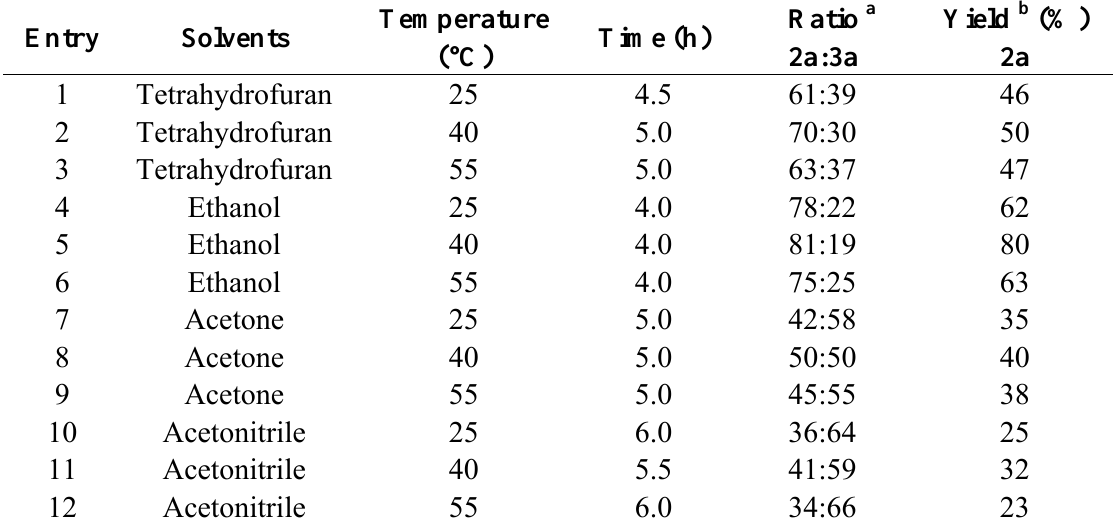
Table 1. Solvent effects on the monohydrolysis of 1a using 1.2 equivalents of NaOH.